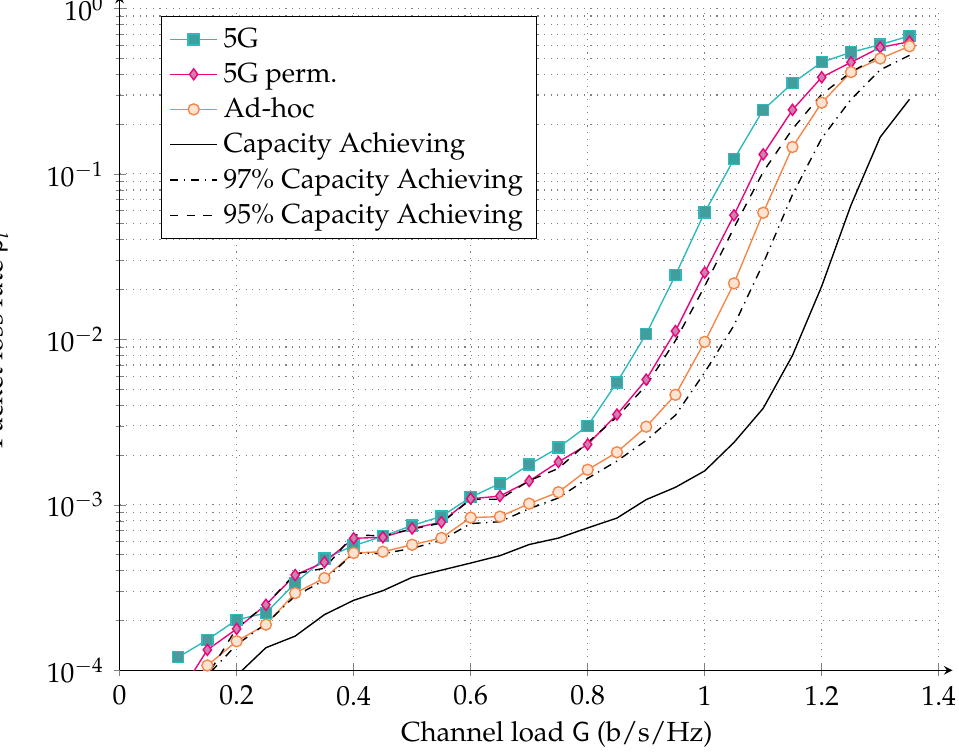
Figure 8. PLR vs. channel load G for the 5G, permuted 5G and ad-hoc LDPC protograph code ensembles for the asynchronous RA setting with an abstracted physical layer. The 5G corresponds to the ensemble with base matrix B 5G . The 5G perm. corresponds to the ensemble with base matrix B π corresponds to the ensemble with base matrix B A